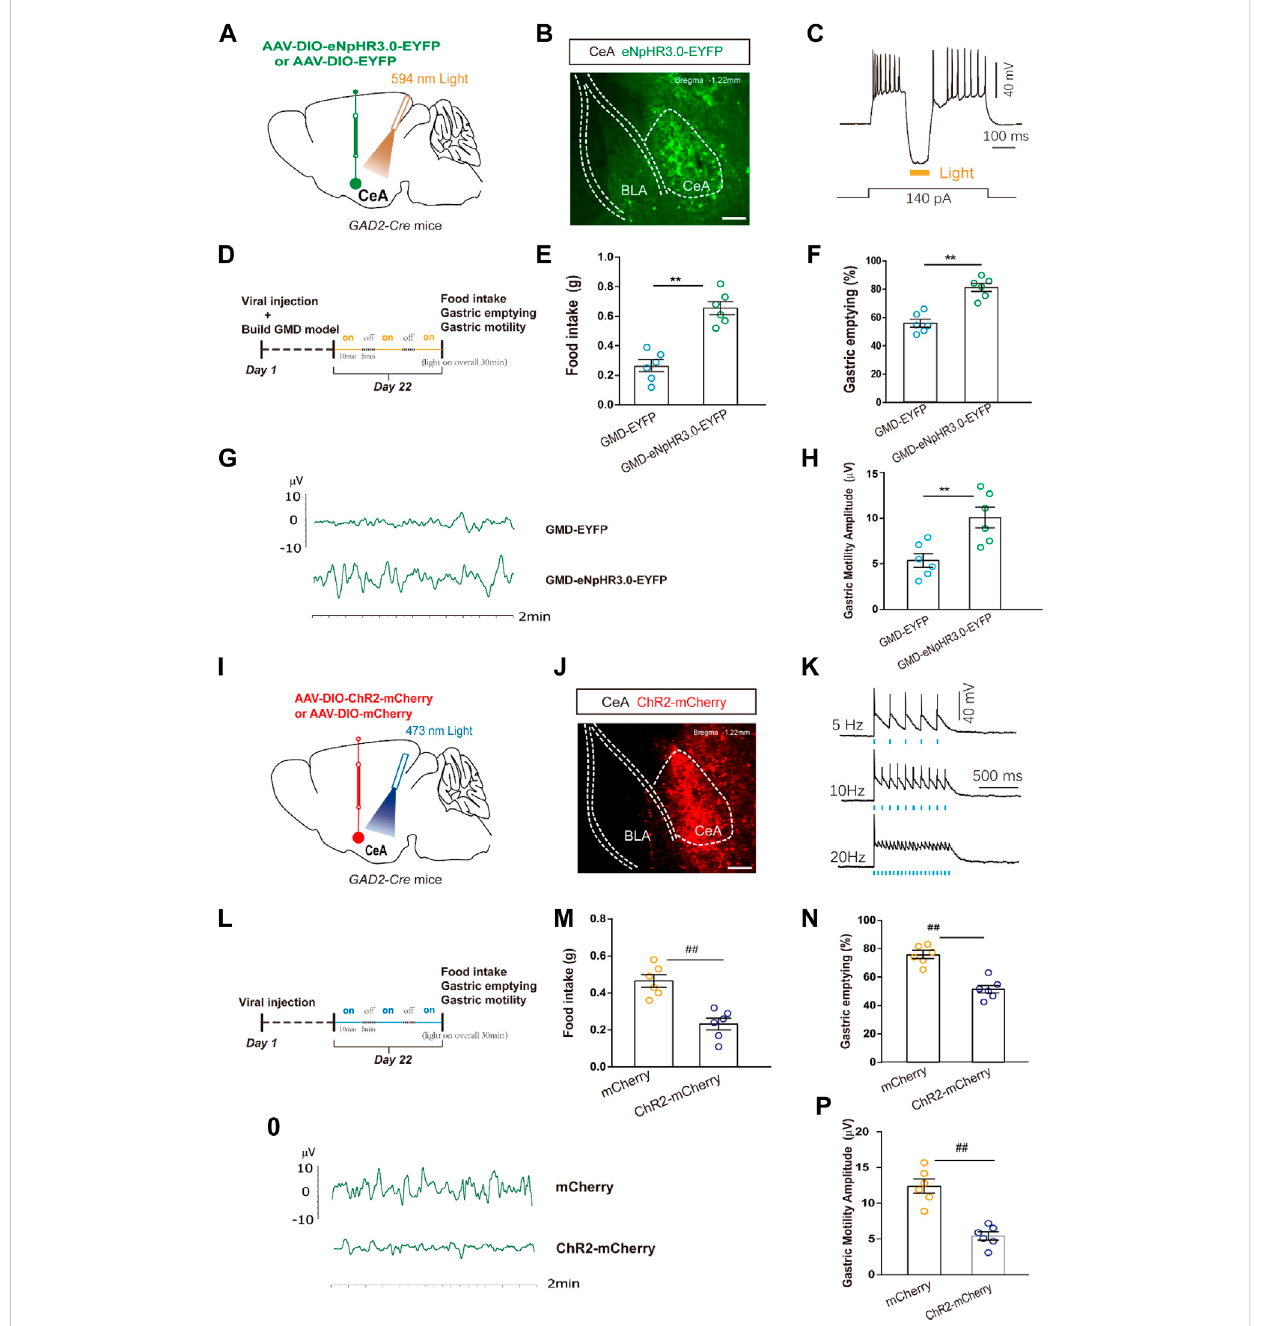
FIGURE 3 The relationship among CeA GABA neurons and gastric motility. (A) Schematic of AAV-DIO-eNpHR3.0-EYFP or AAV-DIO-EYFP viral injection and optic fi breimplantation intheCeA. (B) Representative imageofviralexpression intheCeAof GAD2-Cre mice. (D) Scalebar: 100 μ m. (B) Sampletraces of action potentials evoked by the injected current with photostimulation (594 nm, yellow bar) recorded from eNpHR3.0-EYFP+CeA GABA neurons in acute slices from GAD2-Cre mice. An outline of the optogenetic experimental procedure in GMD mice. (E – H) Gastric motility effects of the optical silencing of CeA GABA neurons with CeA injection of AAV-DIO-eNpHR3.0-EYFP in GAD2-Cre GMD mice [ n = 6 mice per group, food intake (E) , gastric emptying (F) andgastricmotility (G,H) ]. (I) SchematicofAAV-DIO-ChR2-mCherryorAAV-DIO-mCherryviralinjectionandoptic fi breimplantationinthe CeA. Representative image of viral expression in the CeA of GAD2-Cre mice. Scale bar: 100 µm. (K) Sample traces of action potentials evoked by 473 nm light (blue bars) recorded from ChR2 -mCherry + CeA GABA neurons in acute slices from GAD2-Cre mice. (L) An outline of the optogenetic experimental procedure in naive mice. (M – P) Gastric motility effects of the optical activation of CeA GABA neurons [ n = 6 mice per group, food intake (M) , gastric emptying (N) , gastric motility (O, P) ]. All of the data are expressed as the mean ± SEM. ## p < 0.01, ** p < 0.01. Unpaired t -test for (E, F, H, M, N, P)